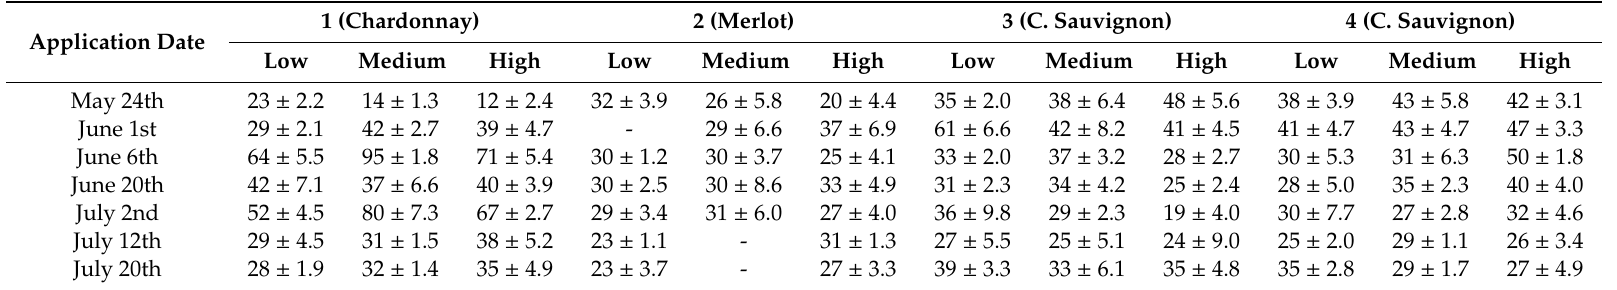
Table 6. Percentage of coverage (mean ± SE of the mean) for each vigor zone in each studied parcel.